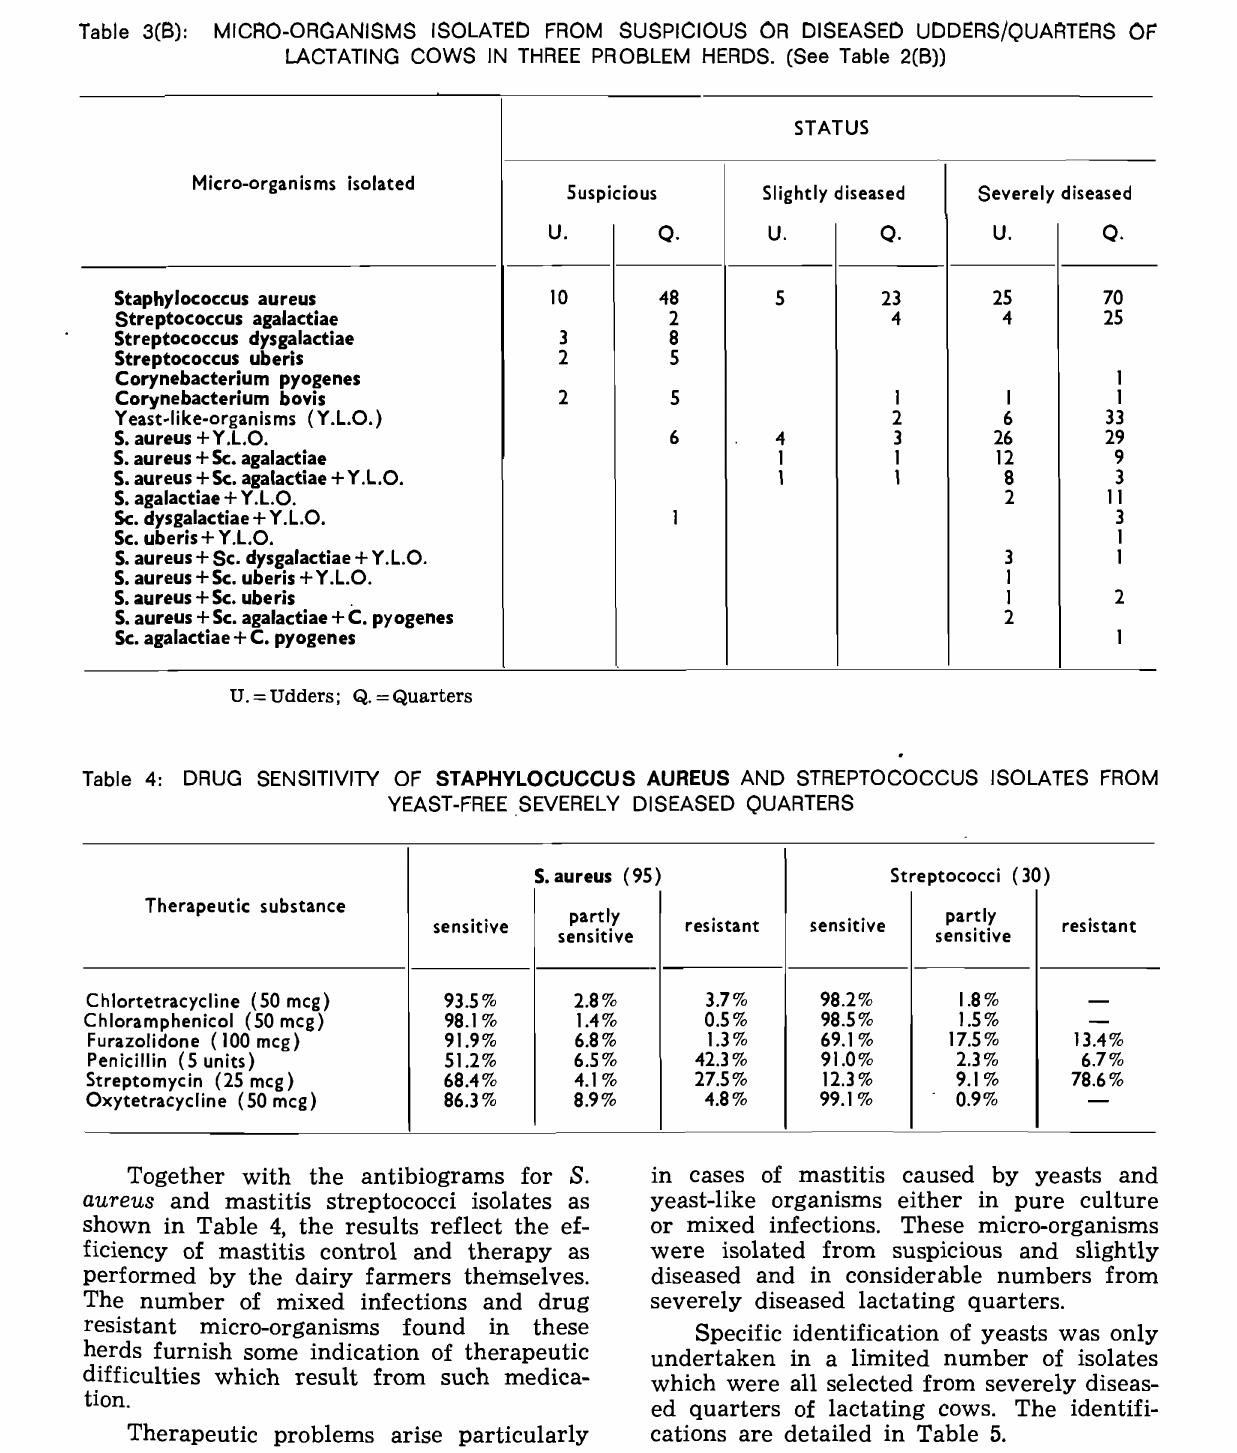
Micro-organisms isolated